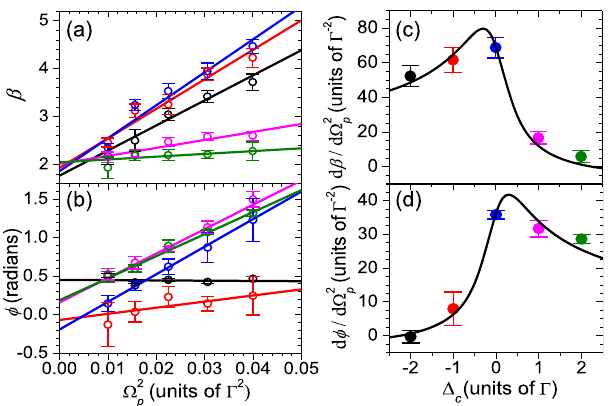
Fig. 2 Attenuation coef fi cient and phase shift due to the dipole – dipole interaction (DDI). a , b Attenuation coef fi cient β and phase shift ϕ at δ = 0 as functions of Ω 2 p in the presence of the DDI. Circles are the experimental data taken with α (optical depth) = 81 ± 3, Ω c = 1.0 Γ , and Δ c = − 2 Γ (black), − 1 Γ (red), 0 (blue), 1 Γ (magenta), and 2 Γ (olive), where Γ = 2 π × 6 MHz. Straight lines are the best fi ts. c , d Circles are data points of the slope of a straight line in ( a ) and ( b ) versus the corresponding Δ c . Black lines are the best fi ts, which determine S DDI = 37/ Γ 3/2 in ( c ) and 38/ Γ 3/2 in ( d ). The error bars represent the standard deviation of measured